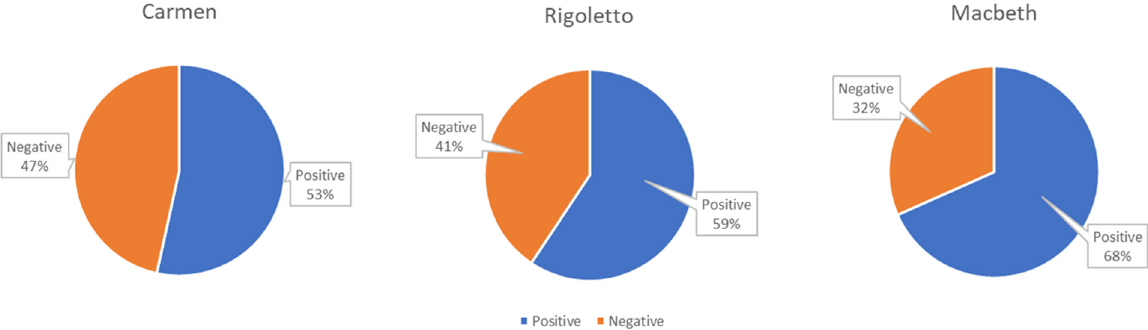
Figure 4. Emotional valence registered during all the monitored performances of the three